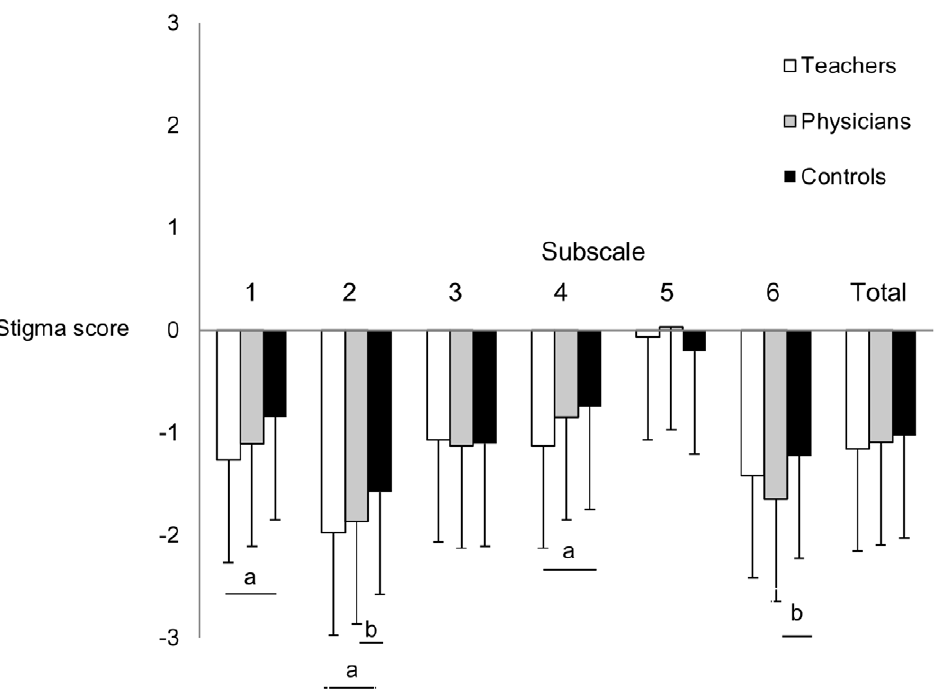
Figure 2. Mean scores of teachers, physicians and controls on each subscale and the total scale. Subscale 1: Reliability and Social Functioning; Subscale 2: Malingering and Misuse of Medication; Subscale 3: Ability to Take Responsibility; Subscale 4: Norm-violating and